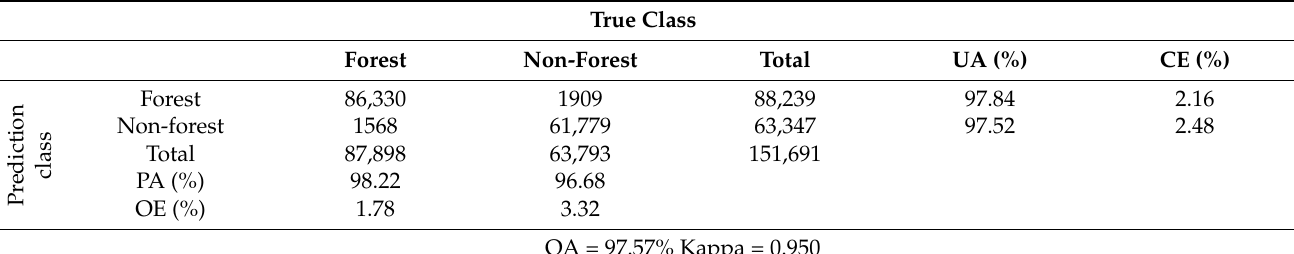
Table 10. Confusion matrix for the forest/non-forest classification map in Yunnan. True Class Forest Non-Forest